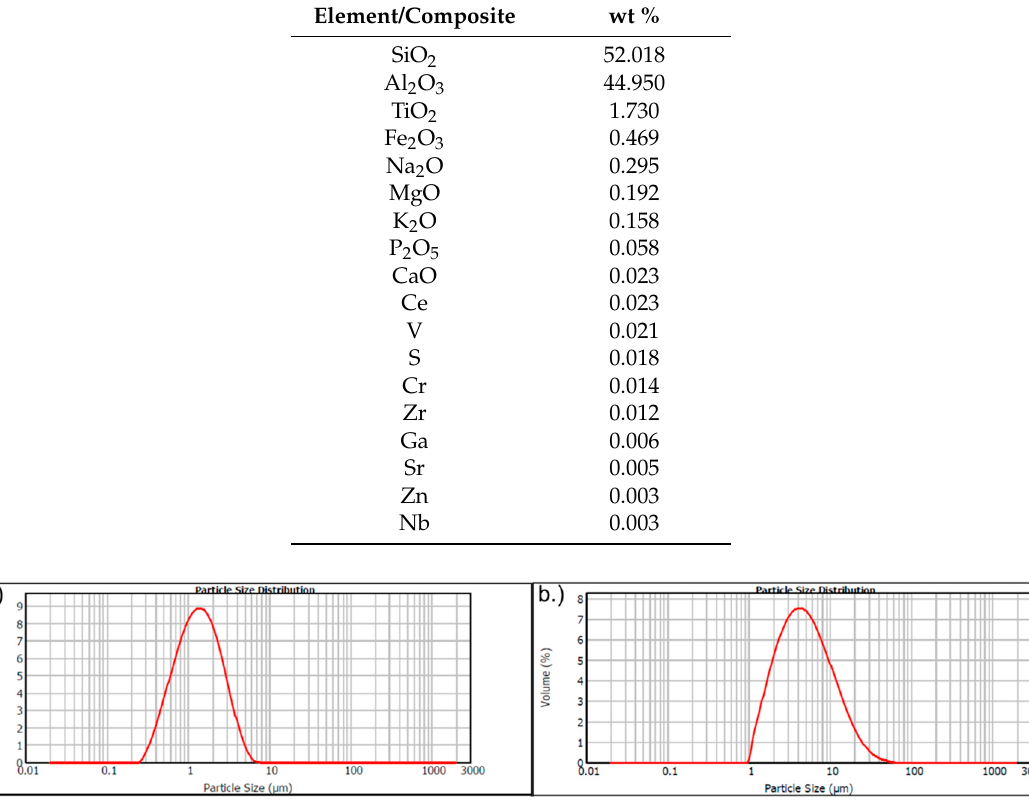
Table 1. Chemical composition of the precursor (MK).